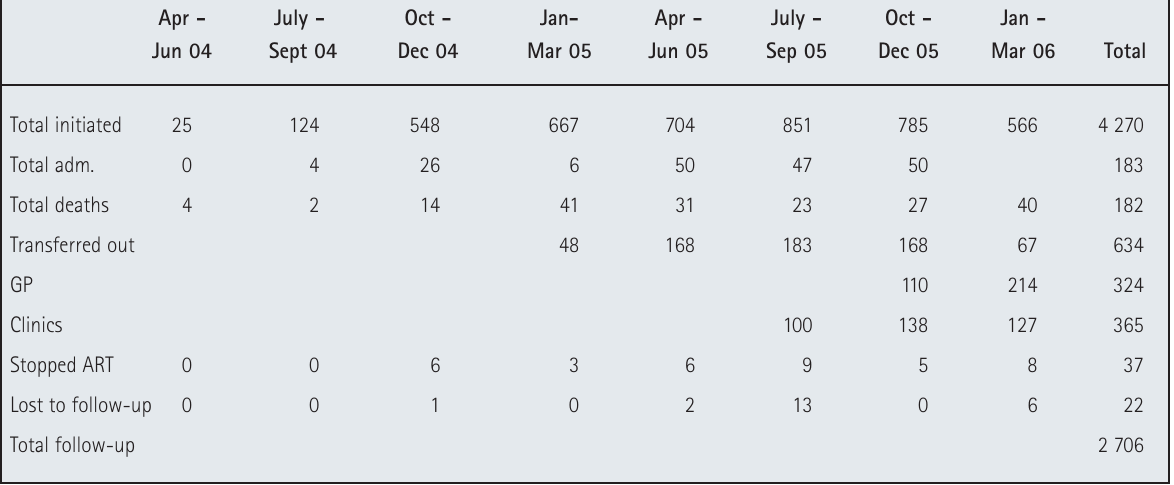
TABLE I. SUMMARY OF QUARTERLY STATS FOR THE WELLNESS UNIT, PRESENTED AT KTC QUARTERLY